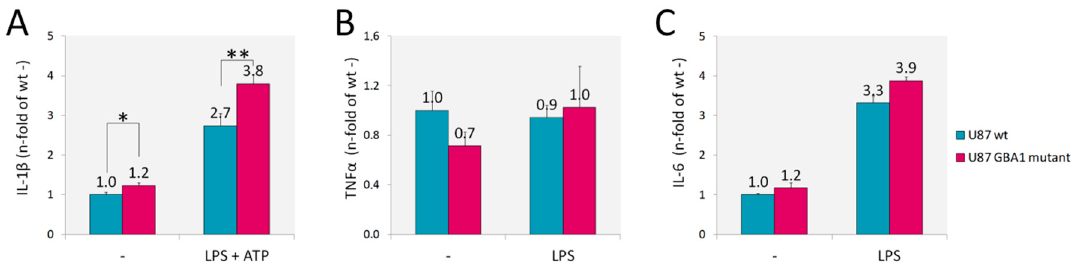
Figure 3. Inflammatory markers. Cytokines levels evaluated by capture ELISA in the supernatant of U87 GBA1 mutant cells showed an increased production of IL-1 β without (-) or with (LPS + ATP) inflammosome activation ( A ). No changes in TNF α ( B ) nor IL-6 ( C ) were detected, with or without LPS stimuli. Results are expressed as mean ± SD of three independent experiments. * p < 0.05, ** p < 0.001.